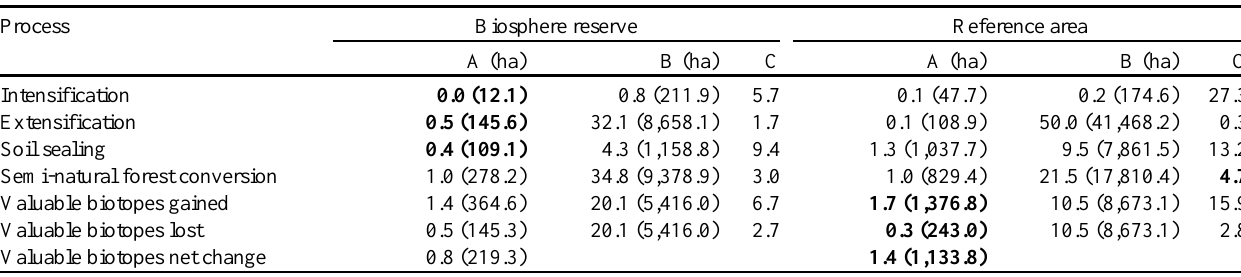
Table 5 . Comparison of key processes inside and outside the reserve (A = % of total area covered, B = % of total area covered by original classes in 1992, C = % of original classes converted by process, bold = best